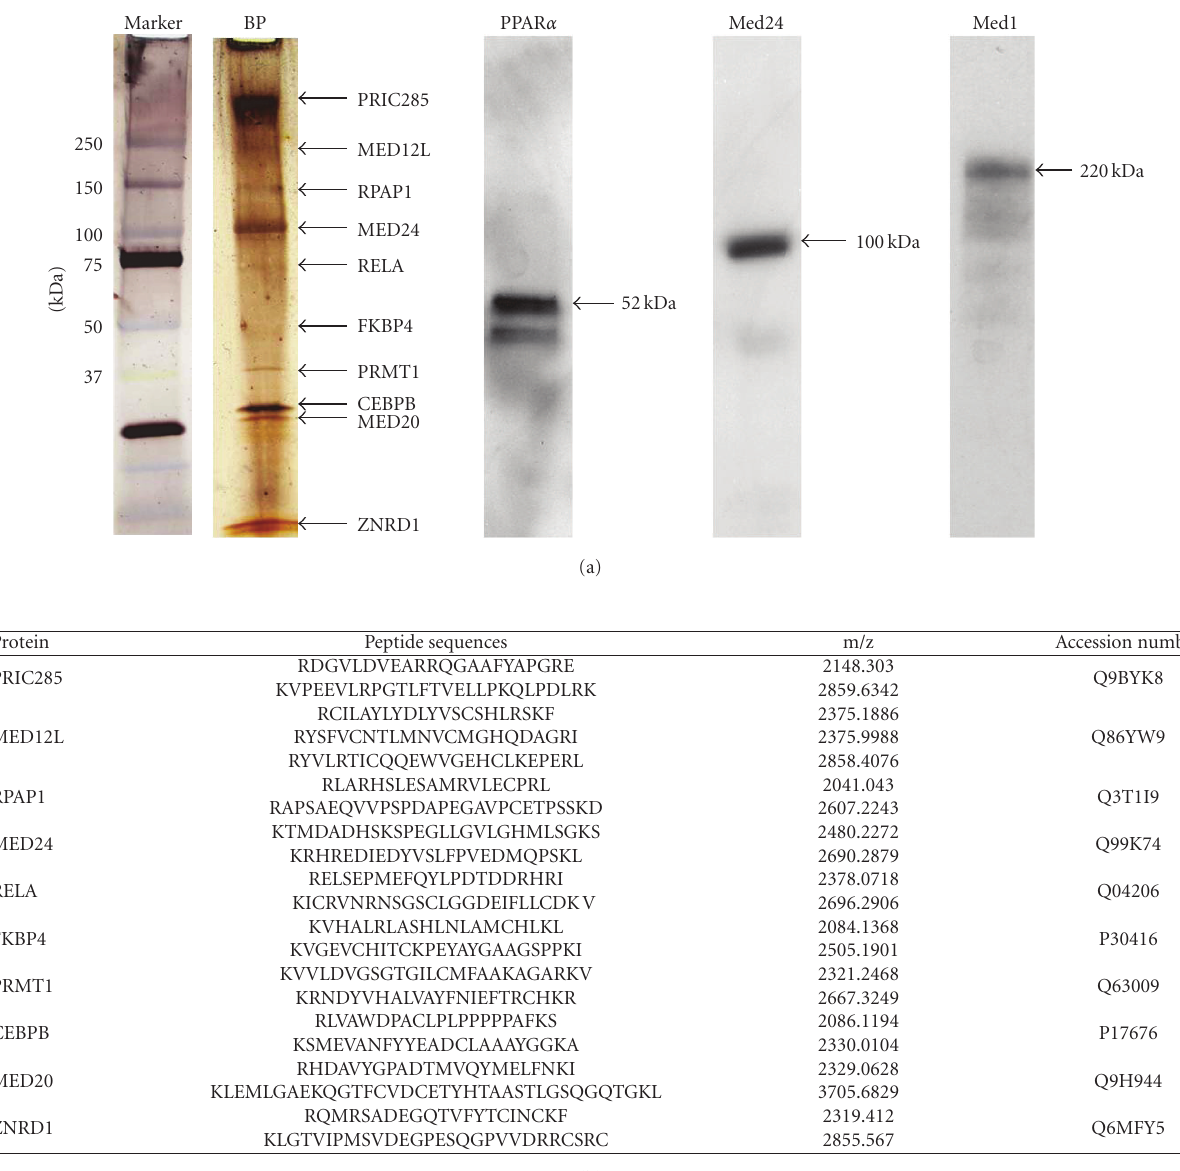
Figure 7: PRIC295-interacting proteins. (a) PRIC295-interacting proteins were isolated using GST- Δ PRIC295 840–1815 (F2) (pGEX- Δ PRIC295 840–1815 ) to pull down interacting proteins from rat liver nuclear extract. Selected bands (lane 2-BP; arrows) were excised from the 4–20% Tris-HCl gel and digested with trypsin to release peptide fragments. (b) Peptide fragments derived from excised bands were subjected to MALDI-TOF analysis. Proteins matching the identities with peptide fragments are shown with some matching peptide sequences, m/z ratios, and accession numbers. In (a), immunoblotting of ciprofibrate-binding protein complex reveals the presence of PPAR α (lane 3), Med24/TRAP100 (lane 4), and Med1 (lane